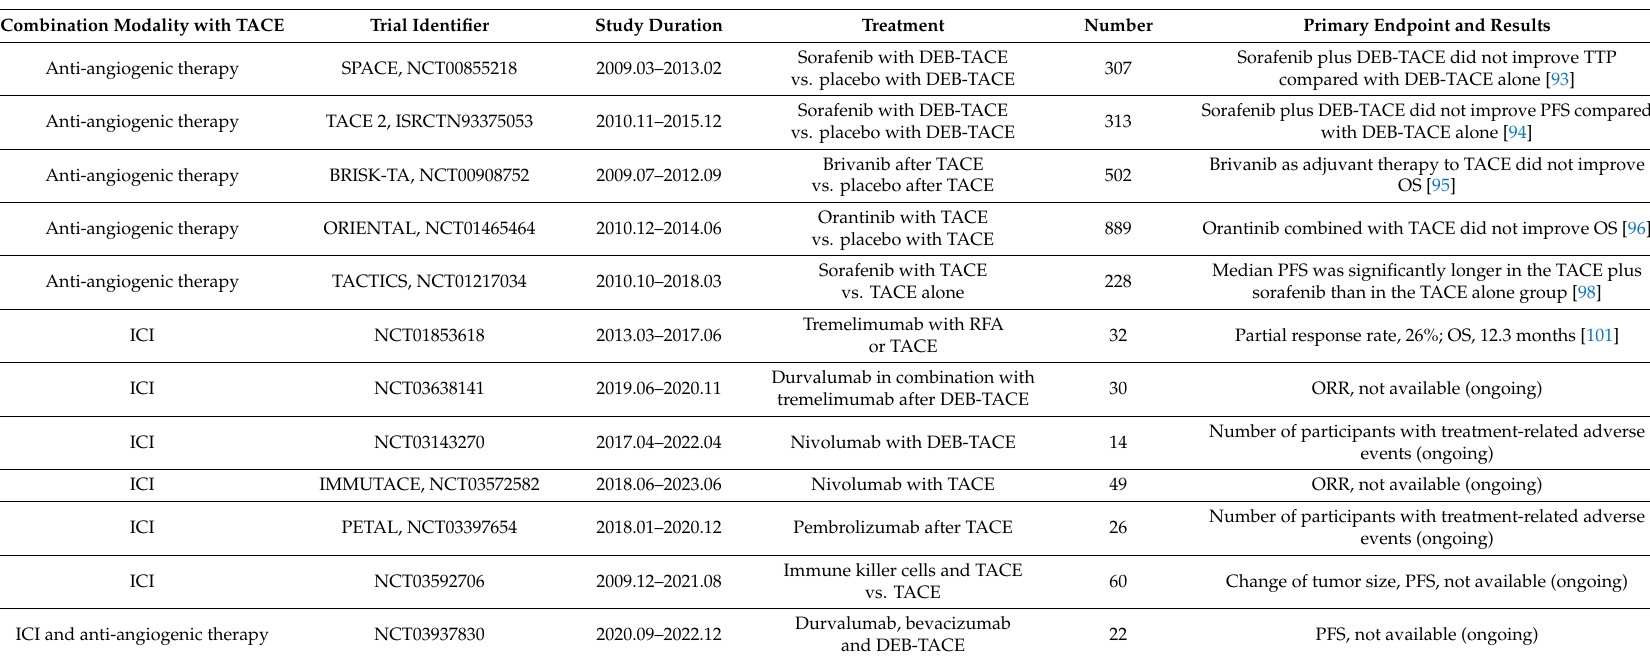
Table 3. Selected studies using the combination of TACE and systemic